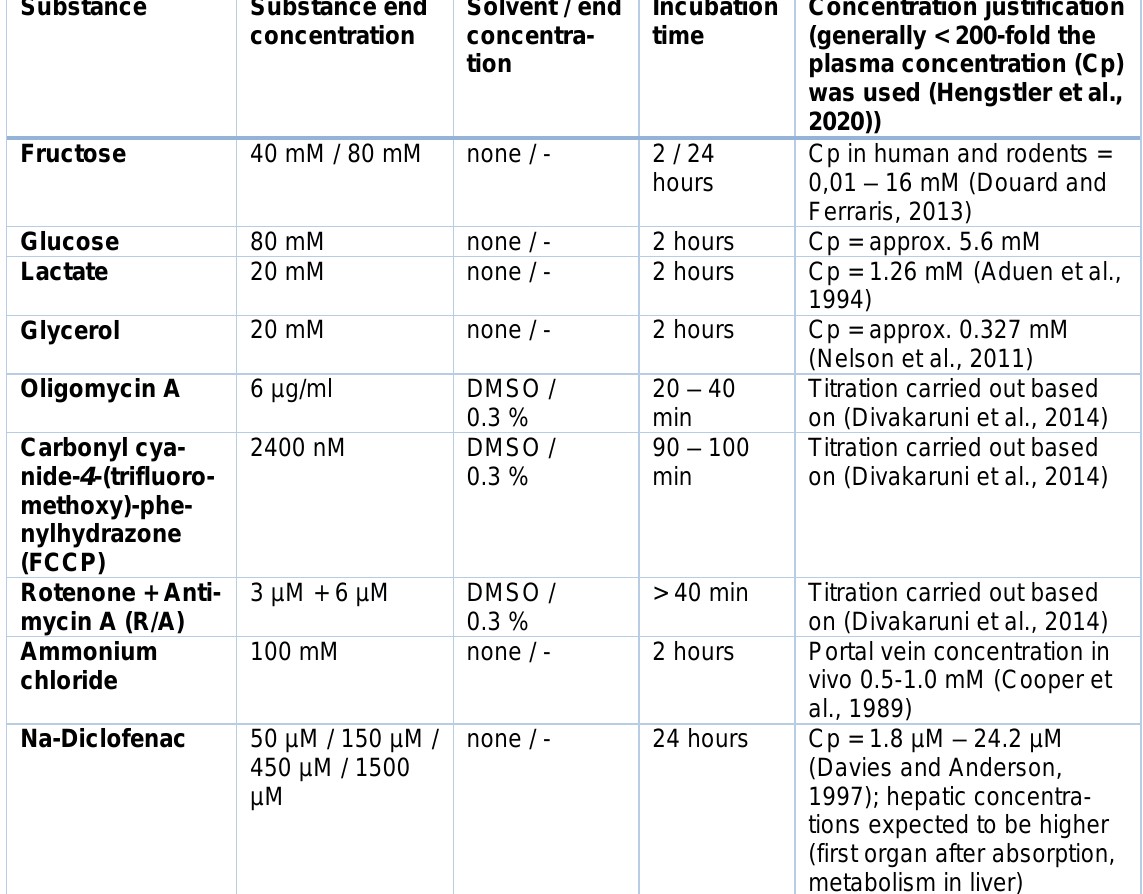
Table 1: Substances used for treating cells cultured in the HepaChip-MP